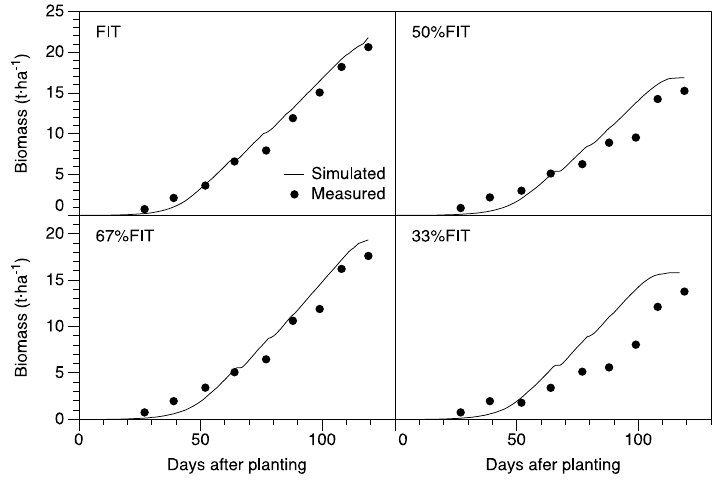
Figure 3. Seasonal evolution of measured and simulated aboveground biomass for the different irrigation treatments used for AquaCrop calibration.